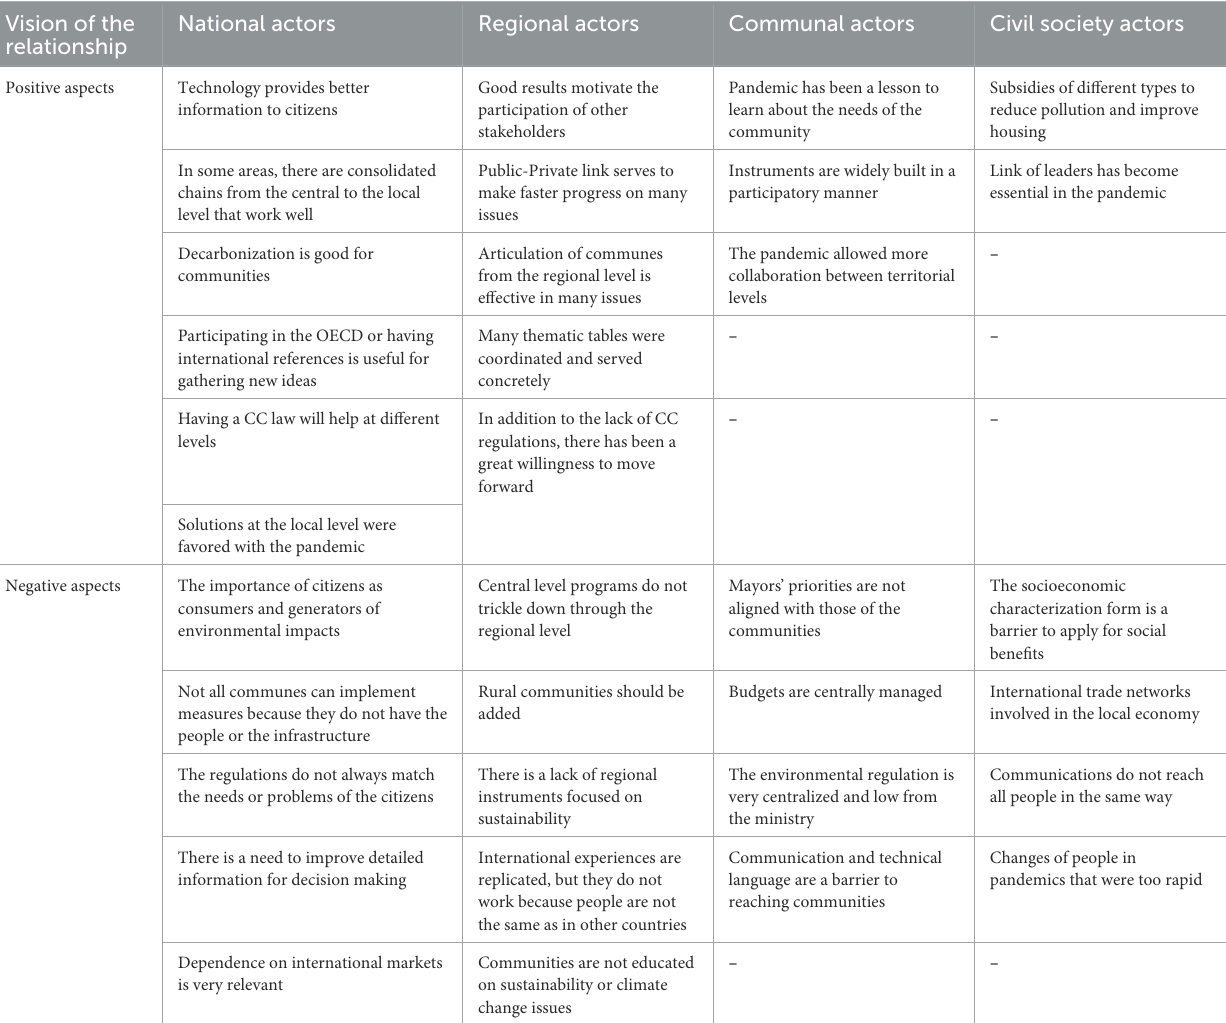
TABLE 3 Summary of the perceptions of the institutional framework for climate change and carbon footprint measurement in Chile, organized by type of stakeholder. Vision of the